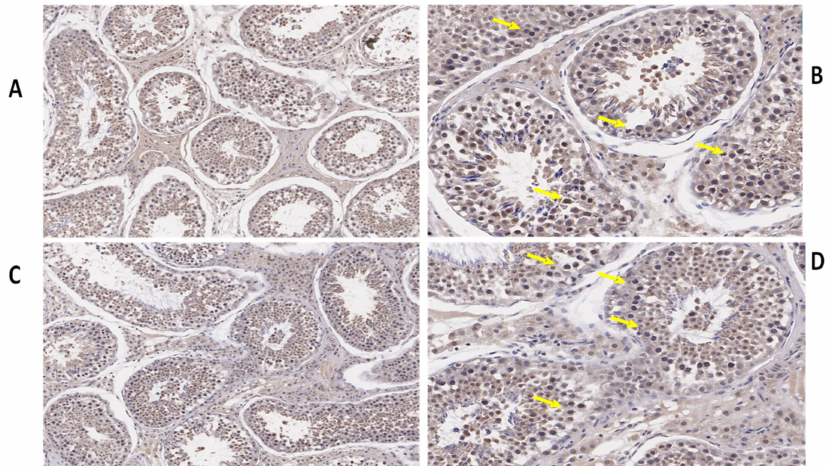
Figure 3. Immunohistochemical localization of TEX11 protein in the testes of yaks under different feeding conditions. Immunohistomestry indicated that TEX11 protein was present in both groups but positive cells (yellow arrow) were more prominent in the tubules of the concentrate supplementation group as compared to the group without concentrate supplementation: ( A , B ) natural grazing plus concentrate supplementation; ( C , D ) natural grazing without concentrate supplementation. Scale bar = 50 µ m ( A – D ).